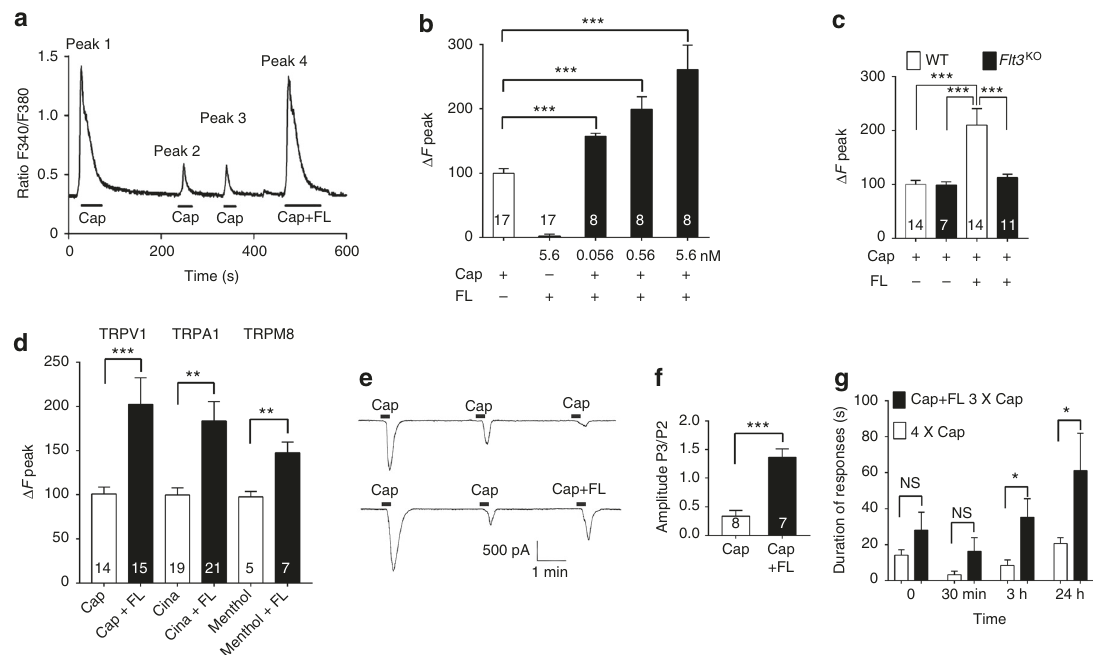
Fig. 2 FL potentiates TRP function in vitro and in vivo. a Traces of [Ca 2 + ] i responses to repeated bath applications of capsaicin (Cap, 2.5 µ M), a selective TRPV1 activator, or capsaicin combined with FL (0.56 nM) on [Ca 2 + ] i levels measured by real-time Ca 2 + cell imaging in cultured DRG neurons. Ratio F340/F380 is the ratio of fl uorescence signals measured at 340 and 380 nm excitation wavelengths. b Effects of capsaicin (Cap, 2.5 µ M) or FL at the indicated concentrations, either alone or in combinations on [Ca 2 + ] i levels, measured at the fourth application of capsaicin as in a . Results are expressed as response amplitudes normalized to capsaicin alone ( Δ F peak). c Effects of FL on capsaicin-induced increased [Ca 2 + ] i levels, measured as in a , in DRG neurons from wild-type (WT) or Flt3 KO mice. d Potentiation by FL (0.56 nM) of increase in [Ca 2 + ] i levels induced by capsaicin (Cap, 2.5 µ M), cinnamaldehyde, Cina (50 µ M), and menthol (1 µ M). e Traces of voltage-clamp whole-cell recording of capsaicin (Cap, 1 µ M)-induced TRPV1 currents and their potentiation by FL (10 nM). f Quanti fi cation of FL effects measured as in e . g In vivo potentiation by FL of capsaicin-induced pain-related behaviors. Animals received either 4 repeated identical injections of capsaicin (15 ng) or a combination of Cap and FL (2 ng) followed by 3 repeated capsaicin injections in the paw, at the indicated times. Results are means ± s.e.m. of data from the number of cells indicated in columns ( b – d , f ) or data from 8 animals ( g ). Unpaired Student t -test. NS non-signi fi cant; * P < 0.05; ** P < 0.01; *** P <